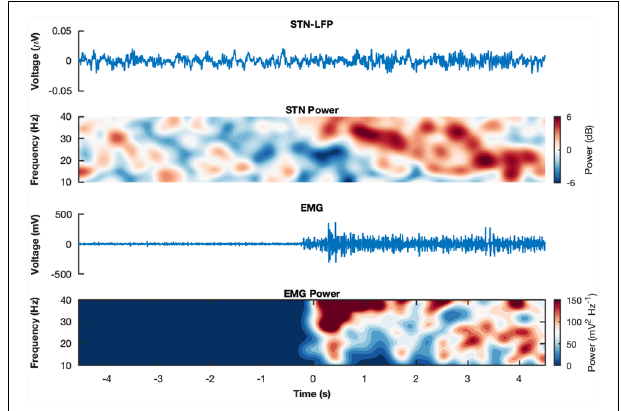
FIGURE 1 | Raw recordings and spectrograms. Example raw subthalamic nucleus (STN)-Local Field Potentials (LFPs) and electromyogram (EMG) epochs from subject wue11 during an isometric contraction in medication state ON. The corresponding spectrograms display the trial-average power spectral densities for the same subject and condition for the STN-LFP and the EMG, respectively. The spectrograms show the decibel change from baseline ( − 4 s to − 2 s relative to movement